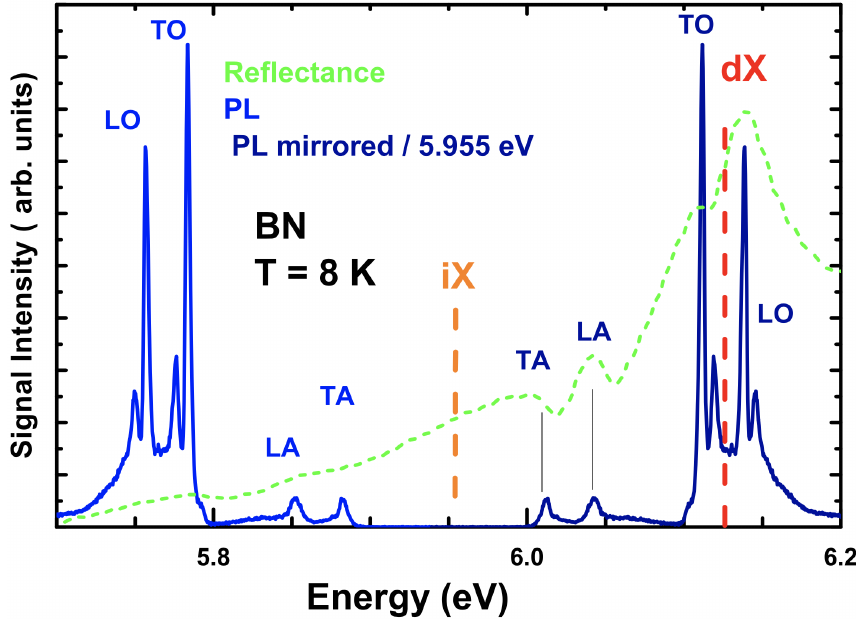
Figure 8. In blue is plotted the low-temperature photoluminescence spectrum of an ultra-pure hBN bulk crystal. In navy is plotted its mirror image relative to the energy (dashed orange line) of the indirect exciton (iX) at 5.955 eV. The reflectivity feature (green dashed line) displays a strong and broad feature at the energy (dashed red line at 6.125 eV) of the direct exciton dX. The series of lower energy features that are, versus energy of iX, one by one the mirror image of another one, is the evidence of indirect transitions that are observed thanks to the absorption of emissions of phonons